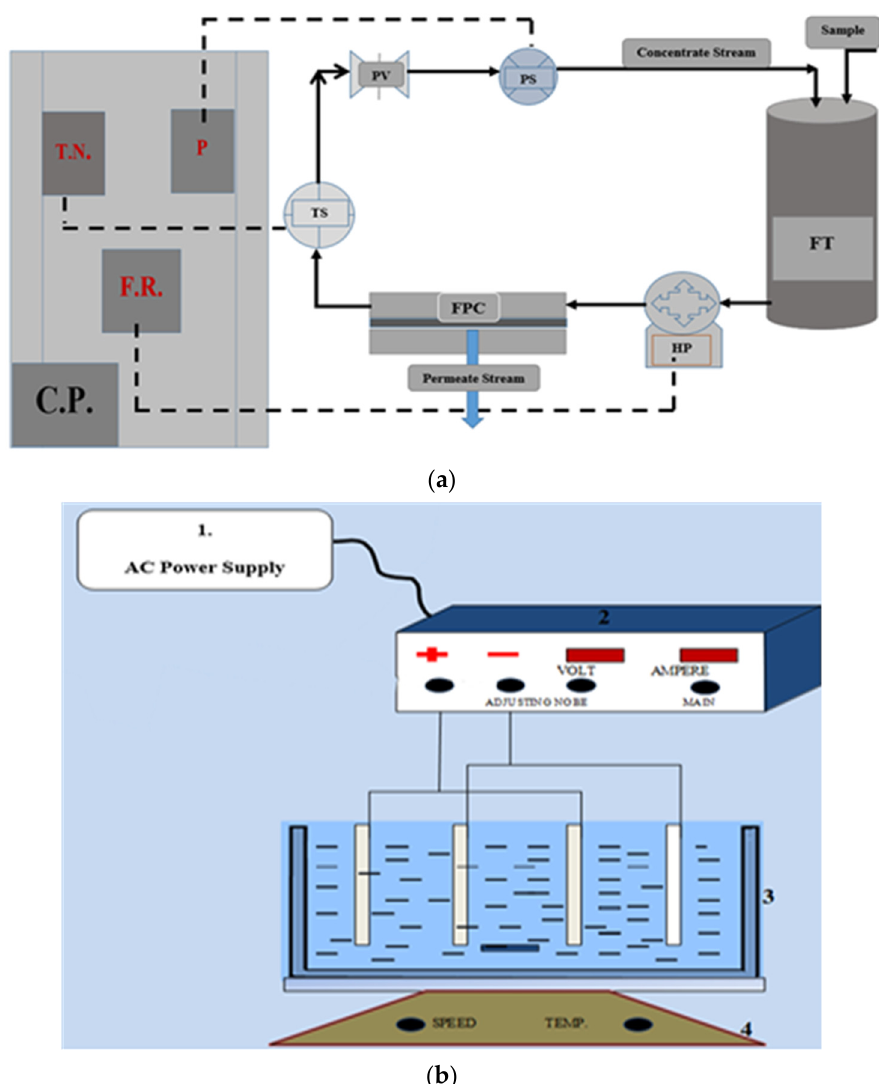
Figure 1. ( a ) Flat Plate Membrane System. (Control Panel, TN = Temperature Node, P = Pressure Node, FR = Flow Rate Controller node, TS = Temperature Sensor, PV = Pressure Valve, PS = Pressure Sensor, FPC = Flat Plate Membrane Cell, HP = High-Pressure Pump, FT = Feed Tank.). ( b ) Laboratory scale experimental setup of electrocoagulation unit. (1-AC, power scheme; 2, direct current supply; 3, treatment vessel, consists of anode and cathode in mono-polar mode, magnetic-bead; 4, magnetic stirrer).